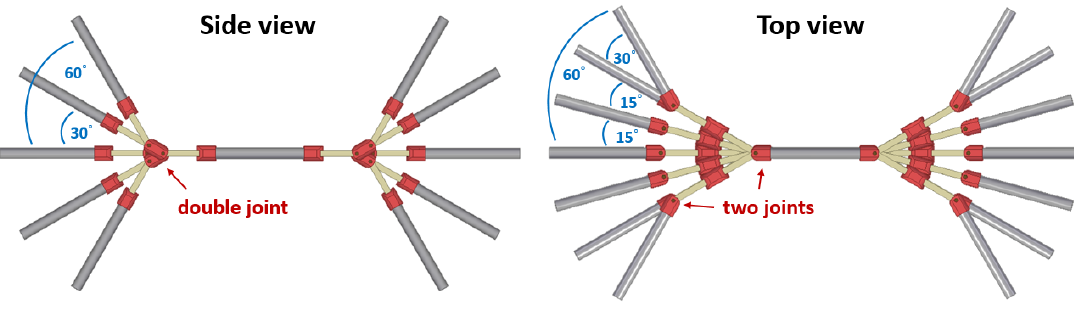
Figure 21. Range of motion of the device from the side and top views.